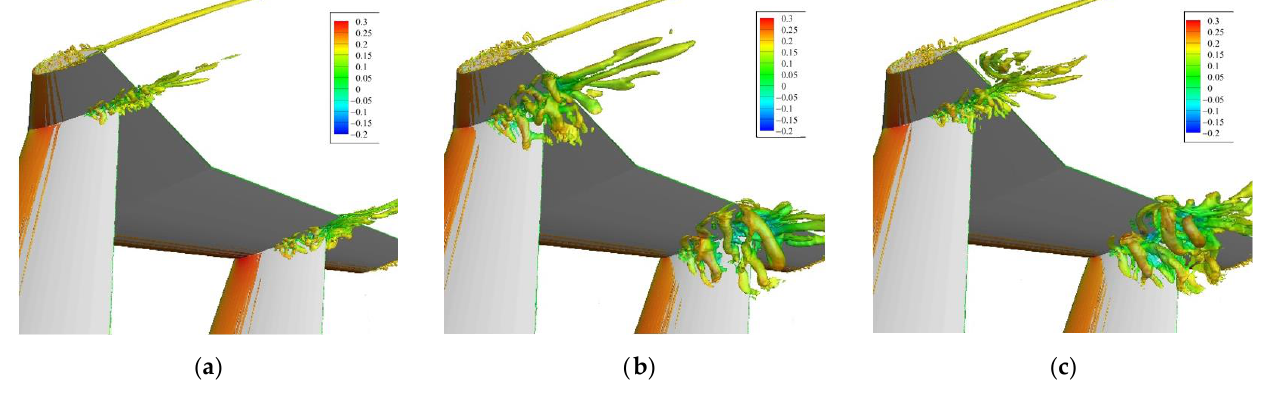
Figure 14. Ω = 0.52 isosurface , looking from the suction side of vertical tail parts: β = ( a ) 0°, ( b ) 2°, Figure 14. Ω = 0.52 isosurface, looking from the suction side of vertical tail parts: β = ( a ) 0 ◦ , ( b ) 2 ◦ ,